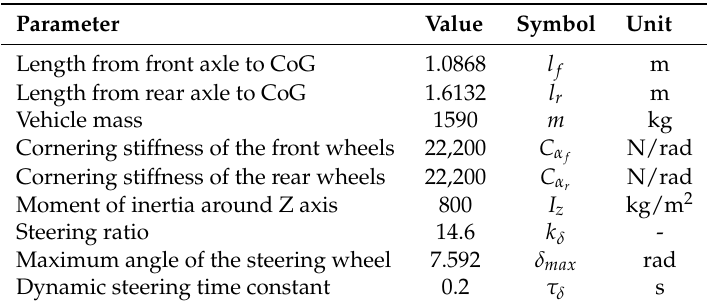
Table 1. Acquired vehicle